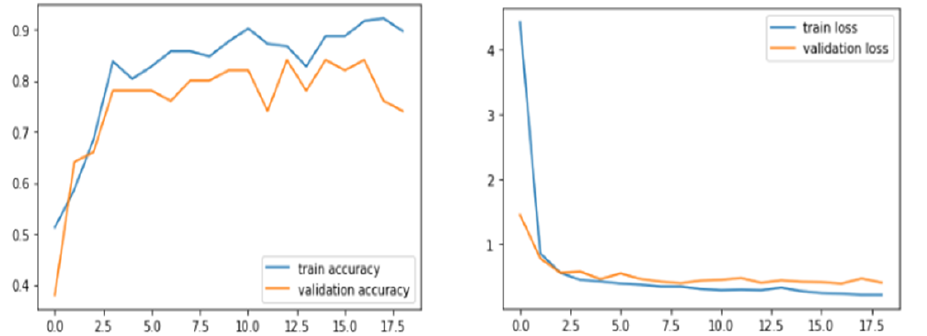
Figure 10. Accuracy and loss for training and